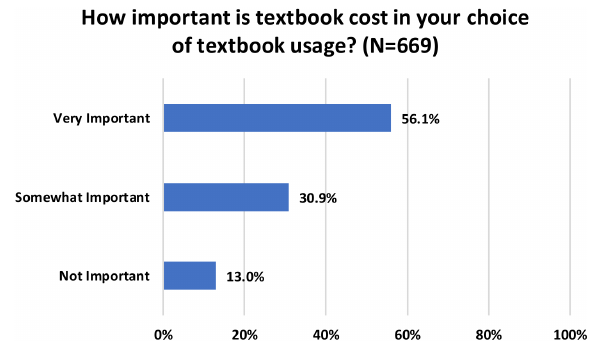
FIG. 3. Students ’ reported consideration of textbook cost when choosing a mode of textbook usage in their introductory physics course. Results from EAP1, AP1, and AP2 are combined in this